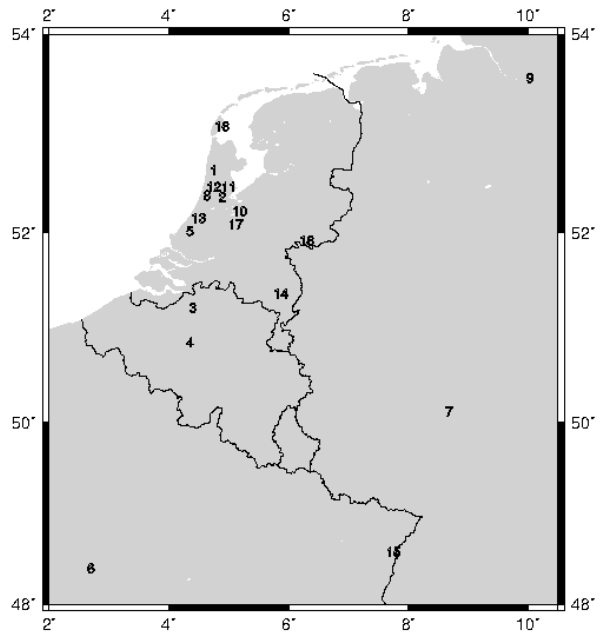
Figure 1. Cities, towns and villages mentioned in the text. The numbers in the map refer to (1) Alkmaar, (2) Amsterdam, (3) Antwerp, (4) Brussels, (5) Delft, (6) Fontainebleu, (7) Frankfurt am Main, (8) Haarlem, (9) Hamburg, (10) Hilversum, (11) Ilpen- dam, (12) Koog aan de Zaan, (13) Leiden, (14) Neerkant, (15) Stras- bourg, (16) Texel, (17) Utrecht, (18) Vethuizen.